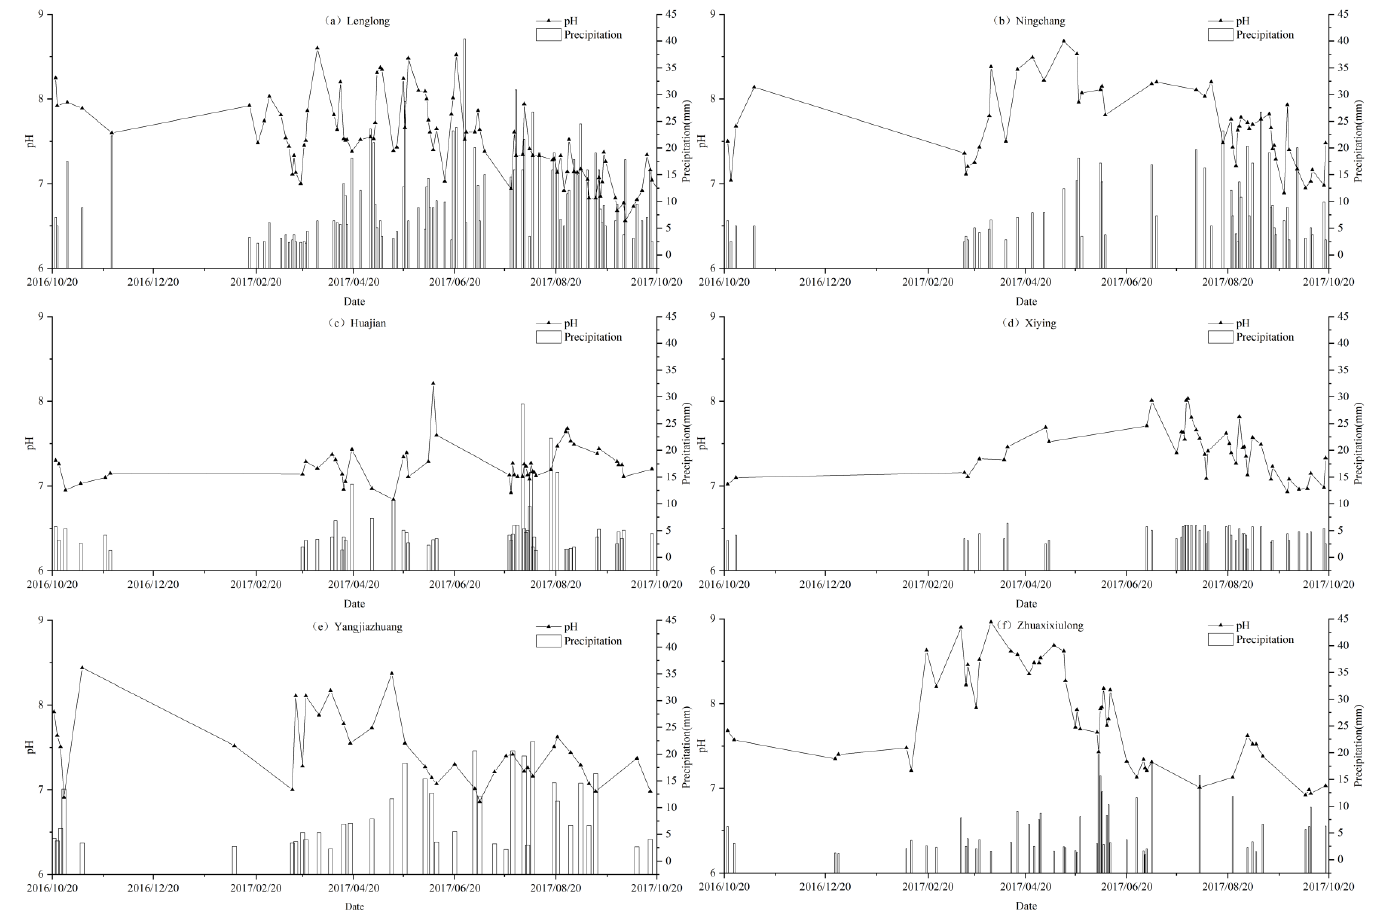
Figure 3. Seasonal variation in precipitation and pH.